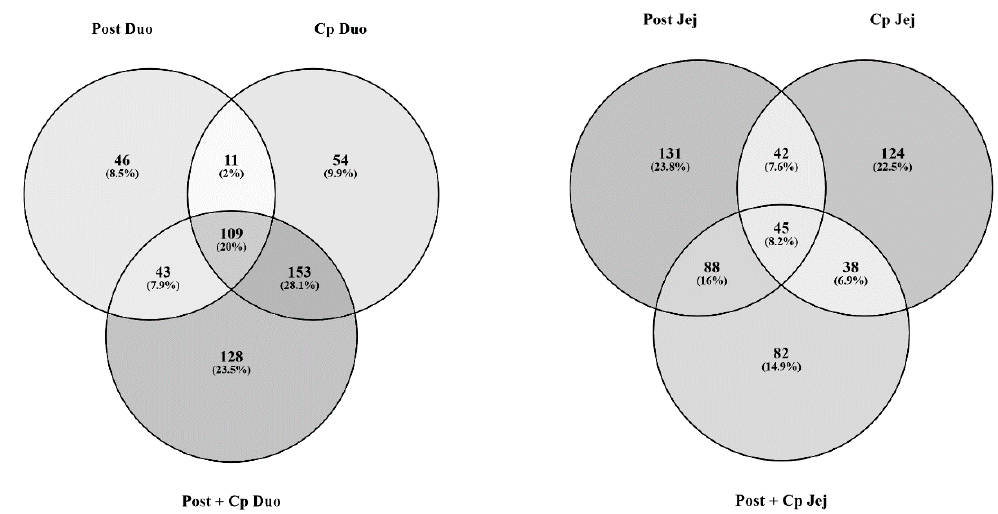
Figure 3. Venn Diagrams of differentially phosphorylated peptides in the postbiotic (Post), C. perfringens challenge (Cp) and postbiotic plus C. perfringens challenge (Post plus Cp) groups in duodenal (Duo) and jejunal (Jej) tissues. Peptides statistically significantly differentially phosphorylated ( p < 0.05) from their respective control tissue were input into a Venn diagram-generating program Venny (http://bioinfogp.cnb.csic.es/tools/venny/).